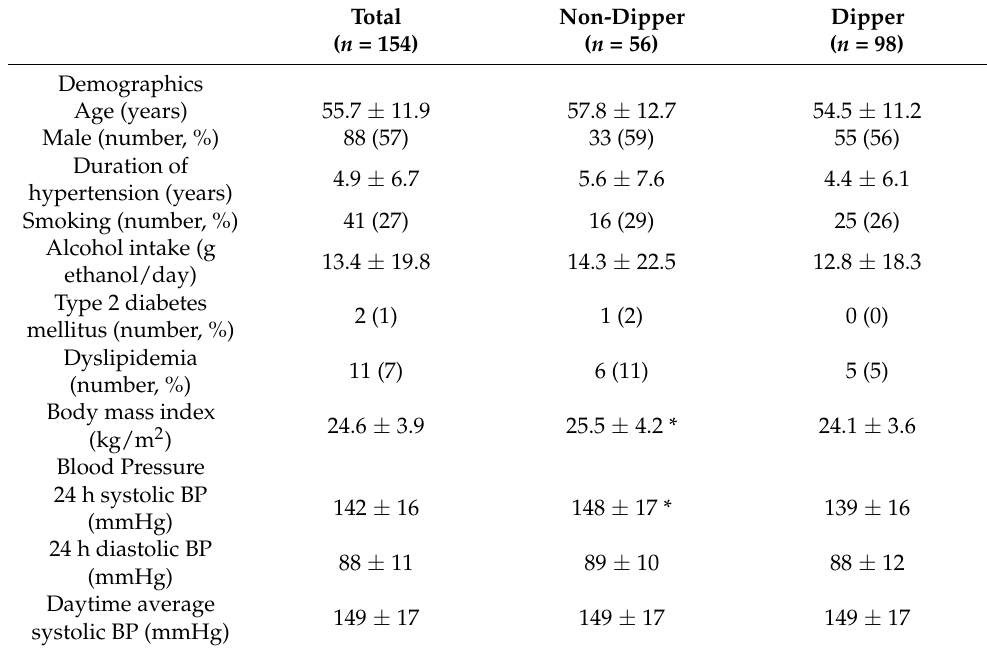
Table 1. Baseline